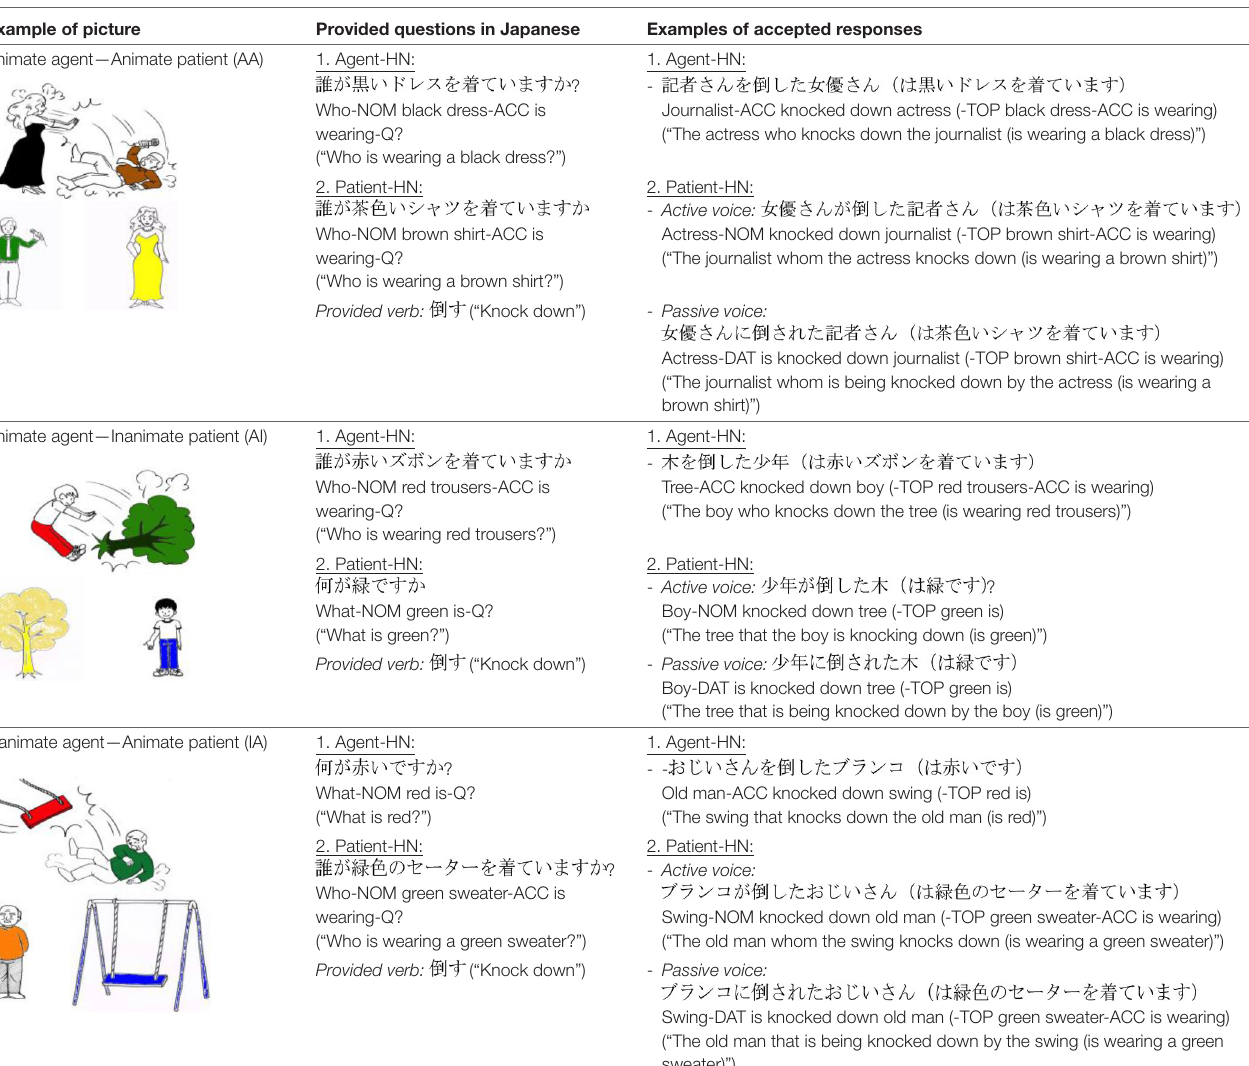
TABLE 3 | Examples of critical items in the three animacy conditions with provided questions and examples of accepted responses in Japanese. Example of